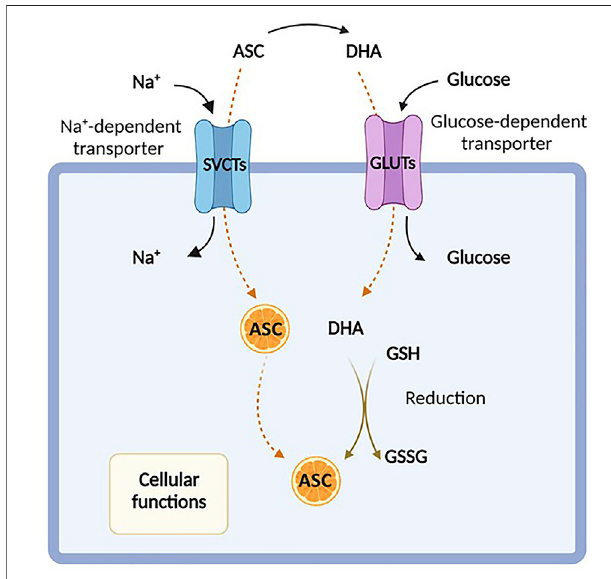
FIGURE 1 | Ascorbic acid uptake. Ascorbic acid, also known as Vitamin C, enters the cell either in its reduced form (ascorbate, ASC) by sodium- dependent vitamin C transporters (SVCTs) or in its oxidized form (dehydroascorbate,DHA) via facilitativeglucosetransporters(GLUTs).In thecytosol,DHAisrapidlyreducedbacktoASCinthepresenceofglutathione (GSH). Created with Biorender.com.